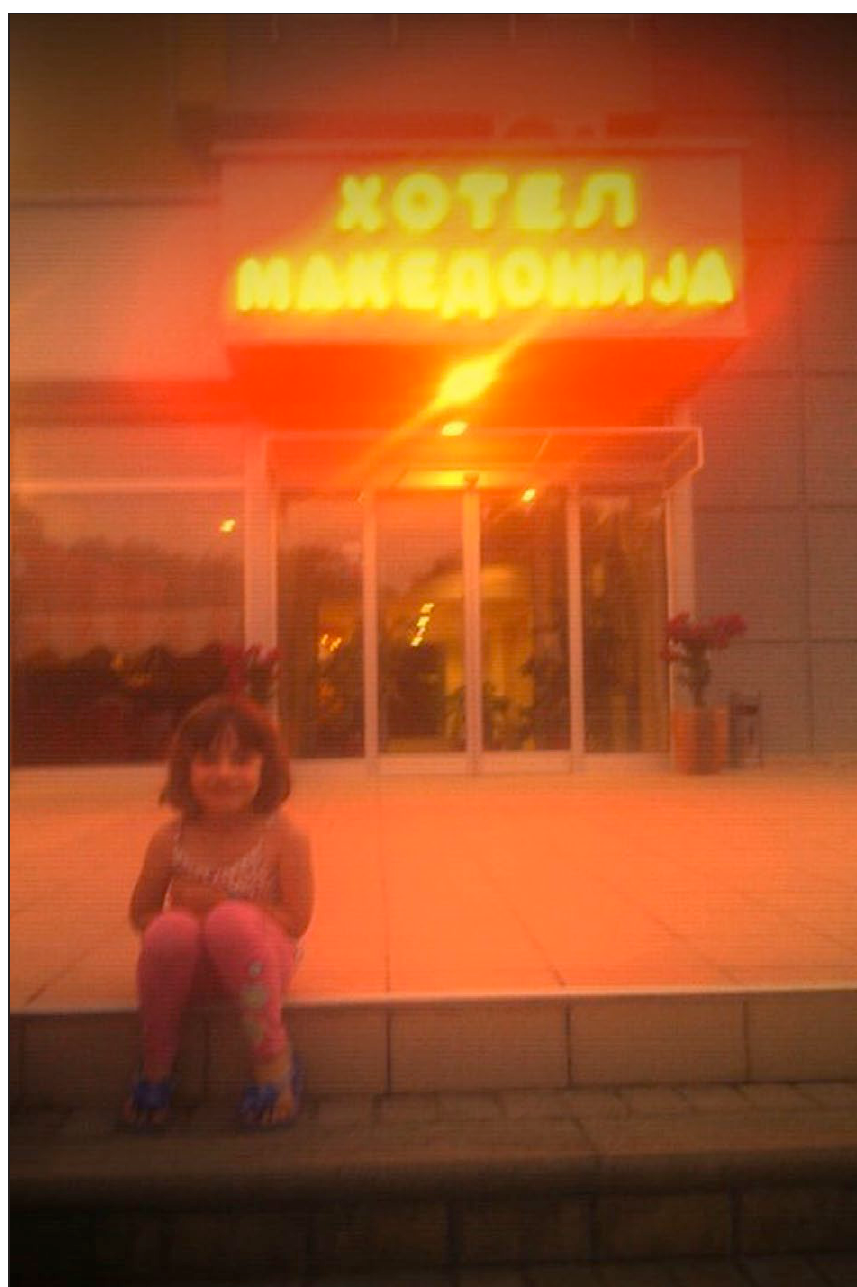
Figure 1: Angelina in